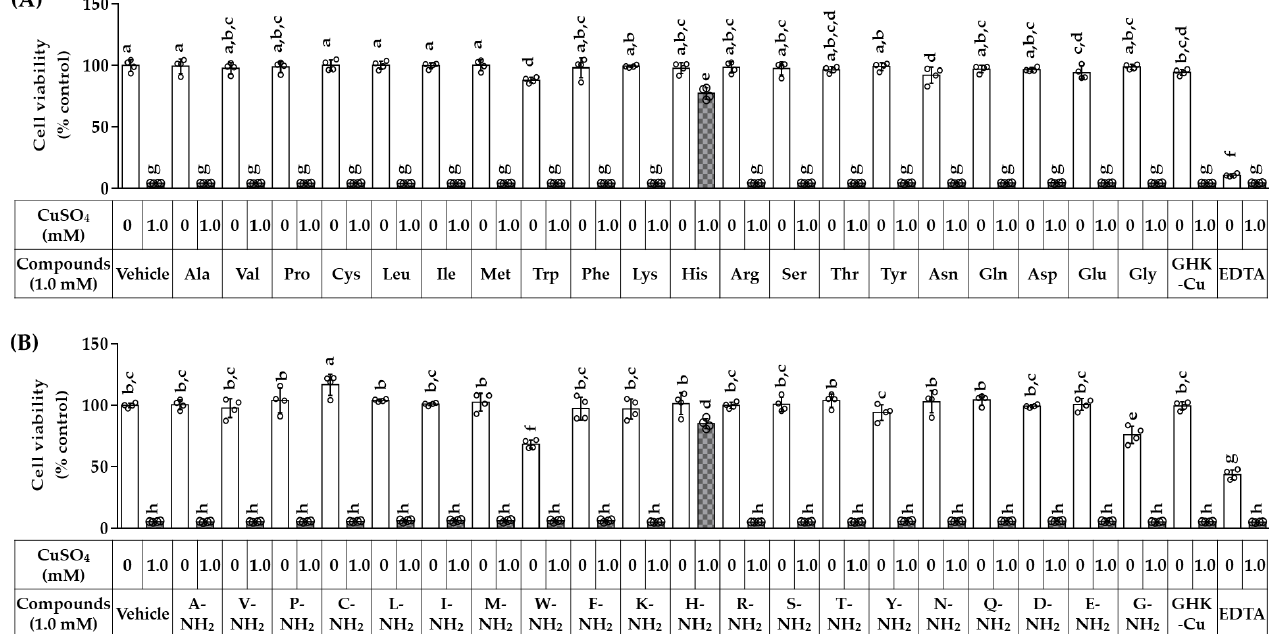
Figure 3. Effects of free amino acids ( A ) and amidated amino acids ( B ) on the viability of HaCaT cells in the absence and presence of CuSO 4 . Cells were treated with a test material at 1.0 mM with no or 1.0 mM CuSO 4 for 48 h. GHK-Cu and EDTA were used as reference compounds. Cell viability was presented as % of the control group (mean ± SD, n = 4). Different lowercase letters (a–h) indicate significantly different means at the p < 0.05 level.